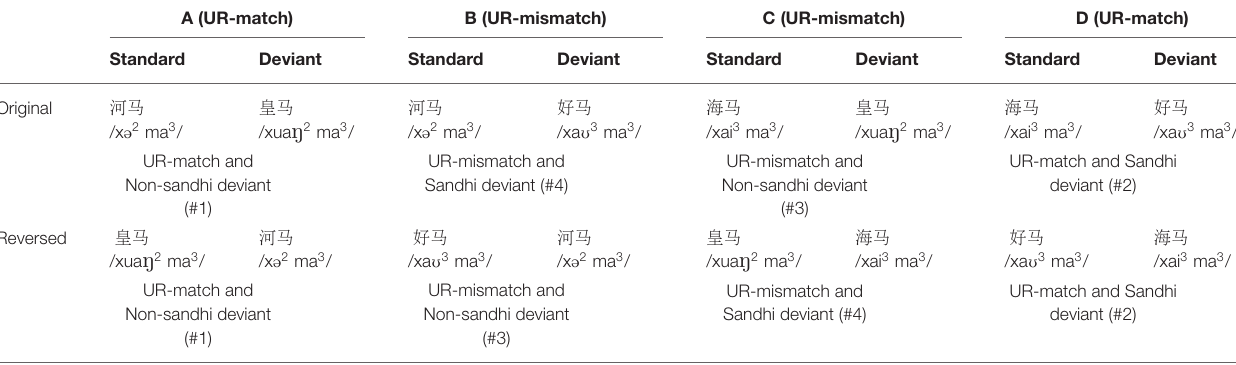
TABLE 3 | A summary of experimental blocks (the phonetic notations are